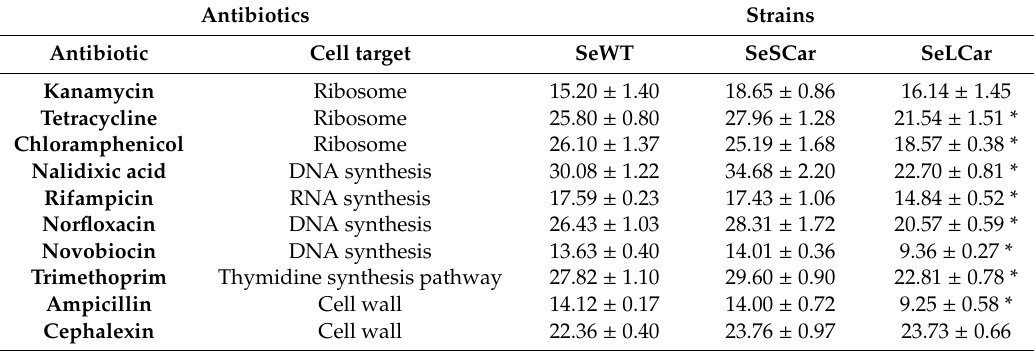
Table 3. Zones of growth inhibition for agar disk di ff usion assays of Salmonella enterica subsp. enterica serovar Typhimurium LT2 wild type (SeWT) and evolved strains: SeSCar (by cyclic exposure to prolonged sublethal treatments of carvacrol) and SeLCar (by cyclic exposure to short lethal treatments of carvacrol) against antibiotics: 30 µ g kanamycin sulfate, 30 µ g tetracycline, 30 µ g